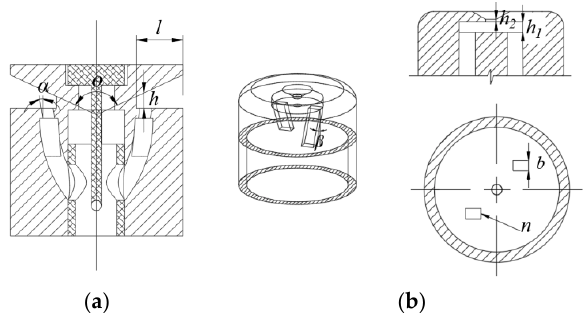
Figure 3. The key hydraulic structure of the sprinkler. ( a ) Structure parameters of irrigation, ( b ) structure parameters of spraying pesticides. α : the diversion hole inclination angle; θ : the refractive cone angle; h : the cone hole distance; l : the refraction cone length; b : the diversion chute width; n : the number of diversion chutes; 𝛽 : the diversion chute inclination angle; h 1 : the rotary acceleration chamber height; h 2 : the nozzle outlet cylindrical section length